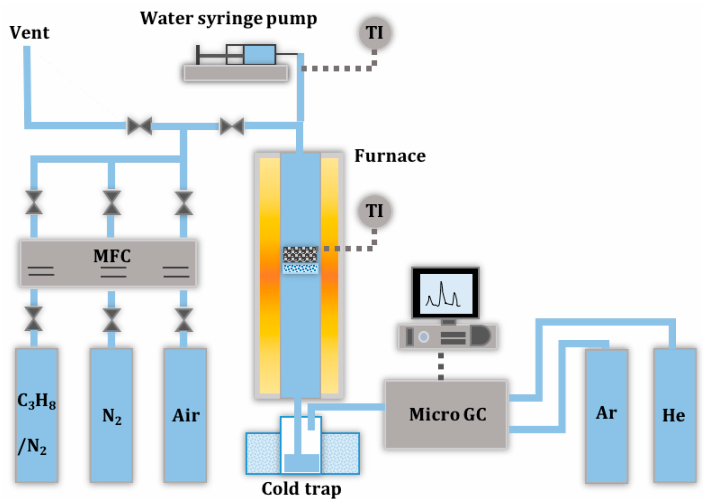
Figure 16. Schematic of the packed bed flow reactor and analysis system. (MFC: Mass Flow Controller, GC: Gas Chromatography, TI: Temperature